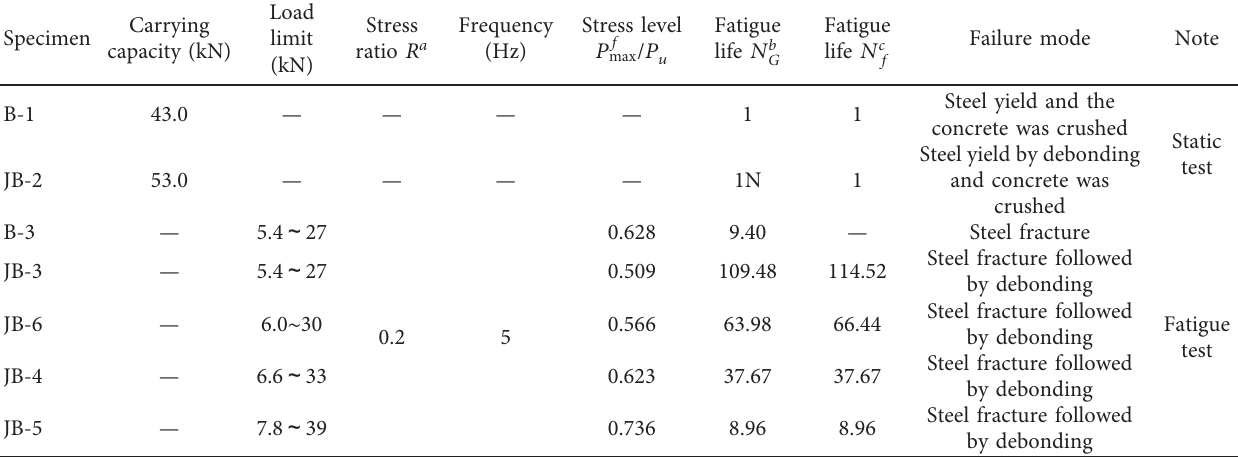
Table 1: Experimental loading conditions and results.